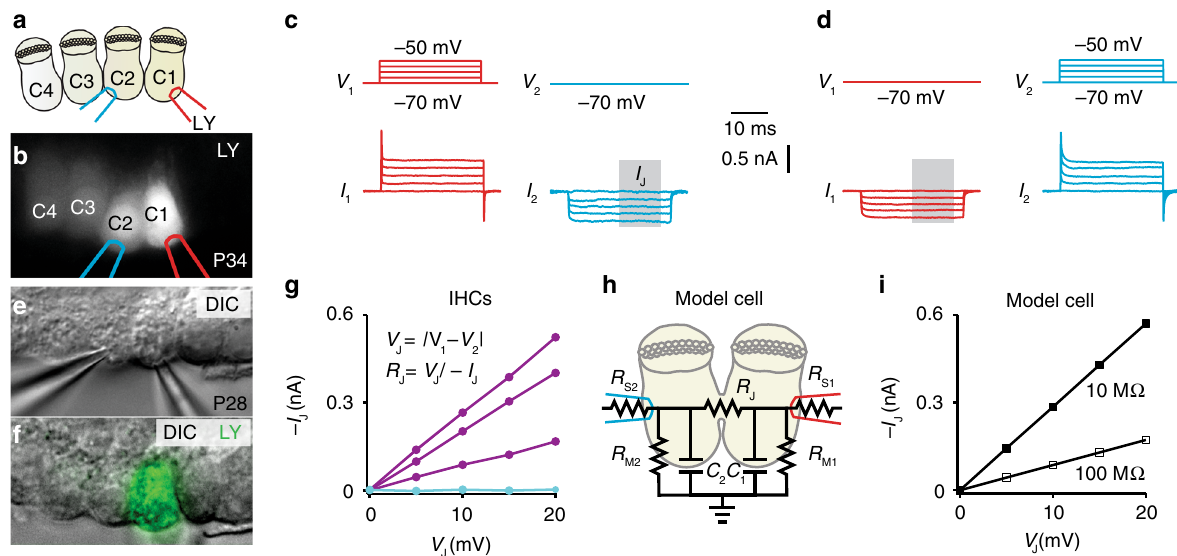
Fig. 3 Dual whole-cell voltage-clamp recordings from dye-coupled IHCs reveal bidirectional low resistance electrical coupling. a , b After observing IHC- to-IHC diffusion of LY from the loaded IHC (C1), the second neighboring coupled IHC (C2) was patched with a LY-free pipette (left). c , d Exemplary dual recording of coupled IHCs (3 recordings in total) demonstrates how depolarizations of one of the IHCs from holding potential ( V H , − 70 mV) produces junctional currents ( I J ) in the second IHC held at V H . e , f In the absence of dye coupling, no I J was observed (cyan in g ). g The steep linear I J – V J curve indicates a large, ohmic conductance between the dye-coupled IHCs (purple, n = 3). Negligible conductance is observed in non-coupled IHCs (cyan, n = 3). h An electrical circuit equivalent of coupled IHCs (cell capacitance, C 1 = C 2 = 10 pF; junctional resistance, R J = 10 M Ω ( fi lled box in i ) or 100 M Ω (empty box in i ); Cell membrane resistance, R M1 = R M2 = 1 G Ω ; Series resistance, R S1 = R S2 = 10 M Ω ) ( i ) produces I J values that frame those of coupled IHCs ( n = 3, compare with g ). V J , junctional voltage difference, I J junctional current, LY lucifer